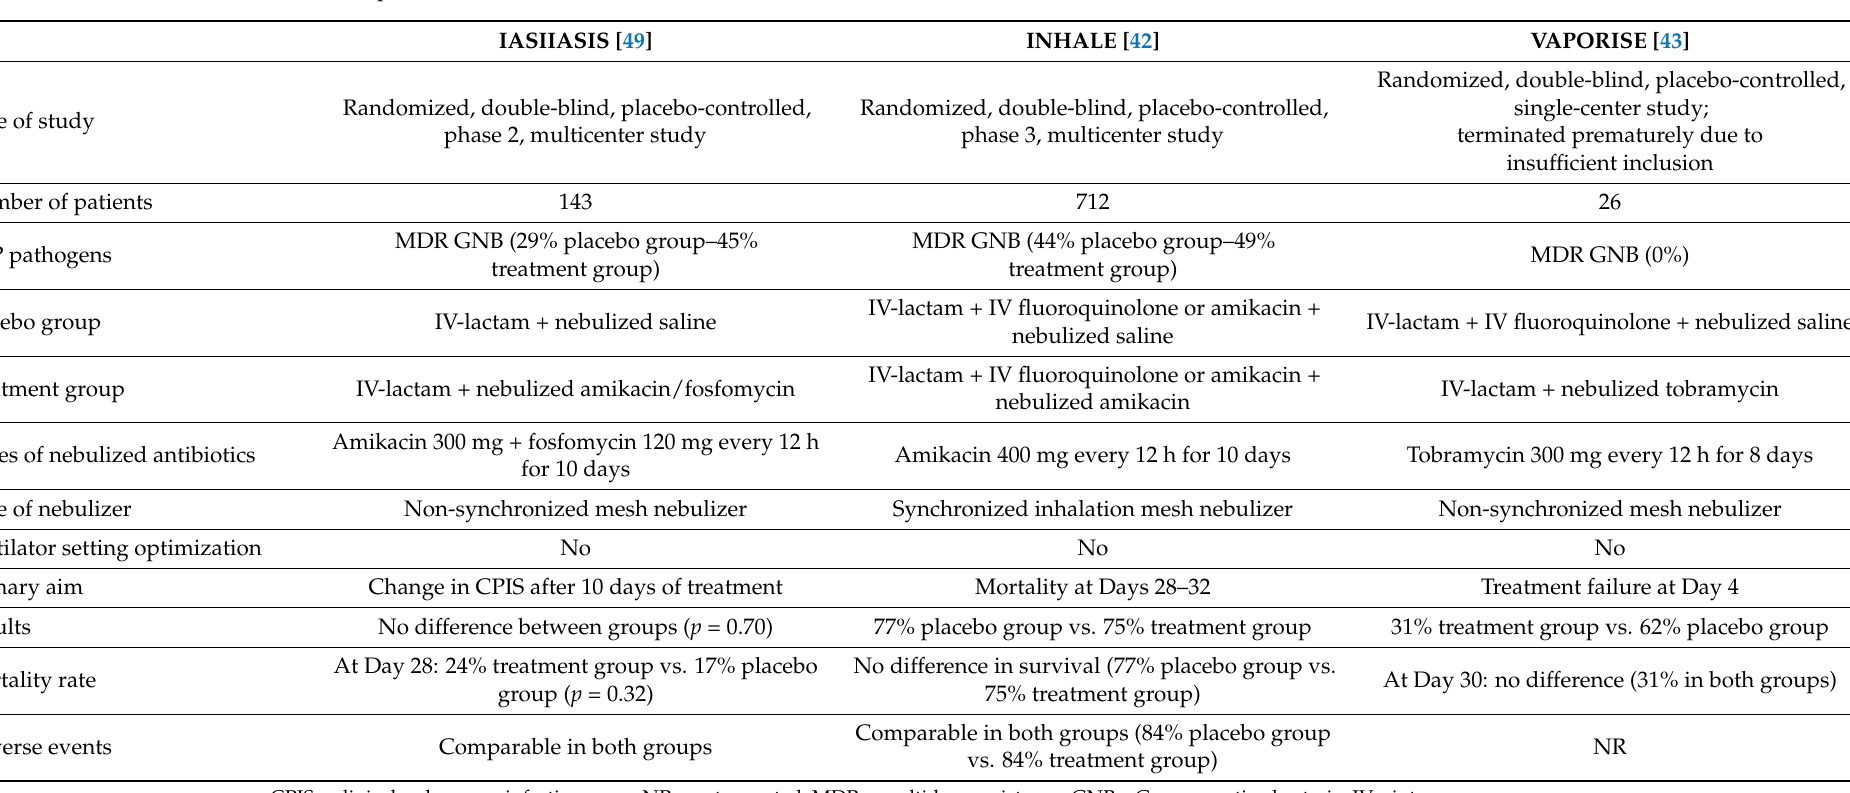
Table 1. Key features of three randomized controlled trials on the use of nebulized aminoglycosides combined with intravenous antibiotics to treat ventilator- associated pneumonia